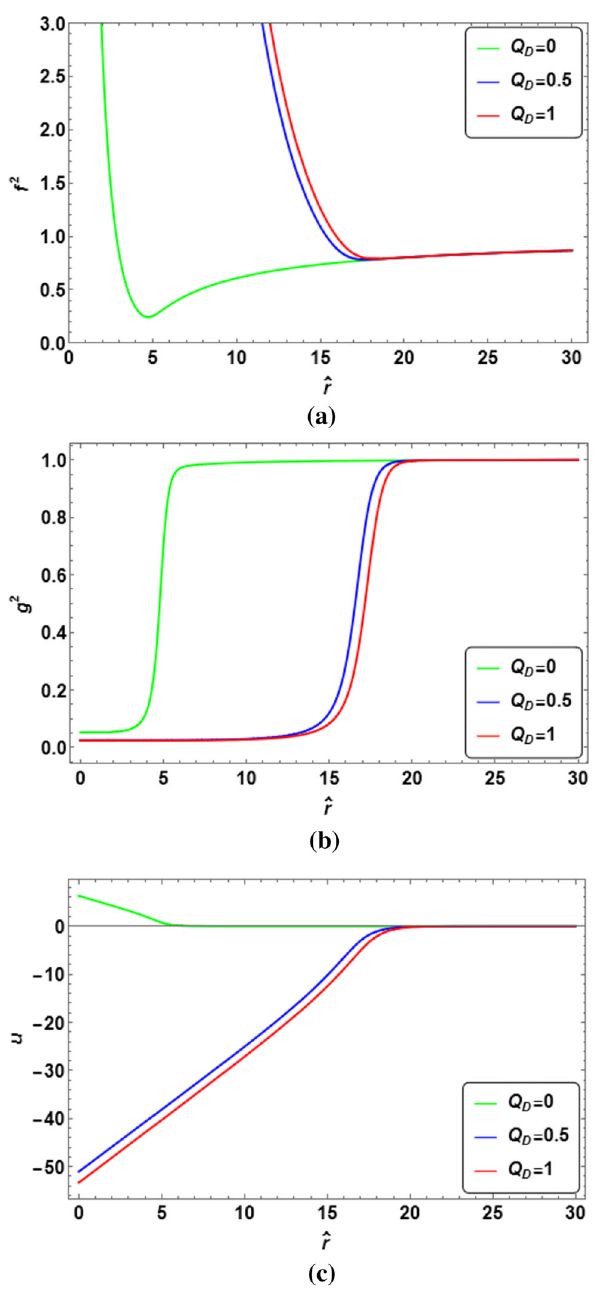
Fig. 1 The spherically-symmetric static EGP system as described by the metric functions f 2 and g 2 , and by the geometric-Proca function u . The solid (dashed) curves correspond to dustless (dusty) case. The dust has zero geometrical charge, that is, Q D = 0. The black hole mass is varied over ˆ M B = 0 . 2 , 1 . 1 , 2, and it is observed that effects of the geometrically-neutral dust is pronounced at large ˆ M B and small ˆ r regimes